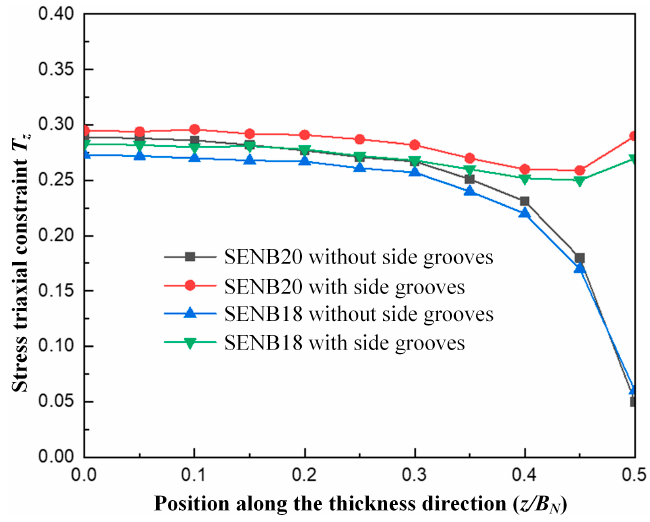
Figure 13. Stress triaxial constraint T z along the thickness direction of the specimen.